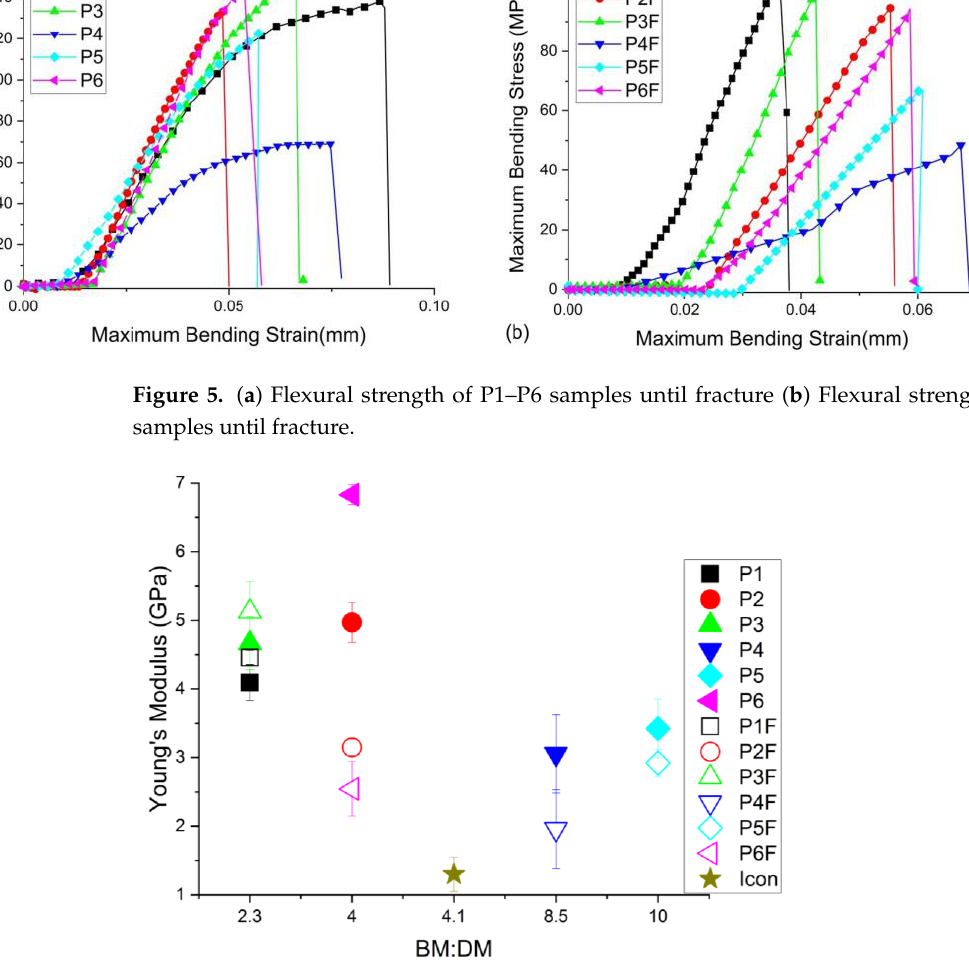
Figure 6. Graphical representation of Young ’ s modulus for experimental infiltrants (without/with filler in the resin mixture), as a function of the ratio between the base and the dilution monomer (BM:DM)